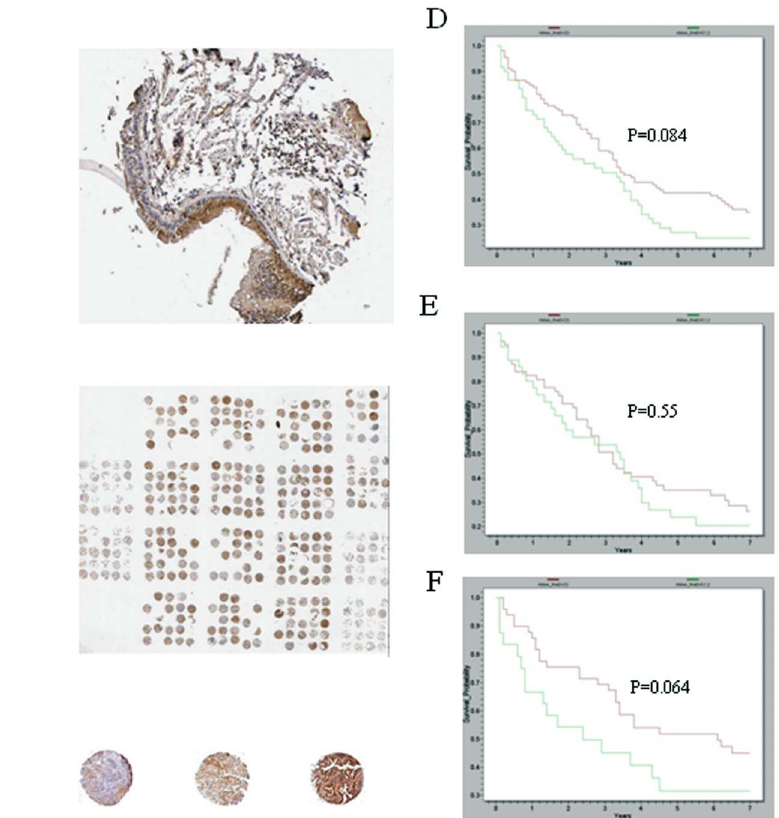
Figure 2. Representative immunohistochemical analysis using the TUSC1 antibody in normal and primary lung tissues. (A) Bronchioepithelium of Normal Lung. The basal layer was not positive for TUSC1 but differentiated cells in the upper layers of epithelium have high TUSC1 expression. Distribution of TUSC1 staining was cytoplasmic, nuclear and nuclear/cytoplasmic in the cells. (B, C) Lung cancer tissue microarray stained with TUSC1 antibody and representative tissue cores (1–3) for each level of staining intensity. (D–F) Kaplan-Meier survival plots for the overall patient (D), adenocarcinoma (E) and squamous cell carcinoma (F). Survival status and the associated P value are indicated. Red line represents tumors with higher expression levels of TUSC1 (score: 3), green line represents tumor with lower expression levels of TUSC1 (score: